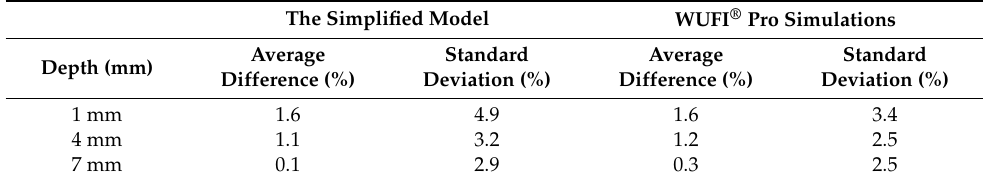
Table 1. Average difference and standard deviation based on hourly values between measured and modelled result in the 100 days measured. The Simplified Model WUFI ® Pro Simulations